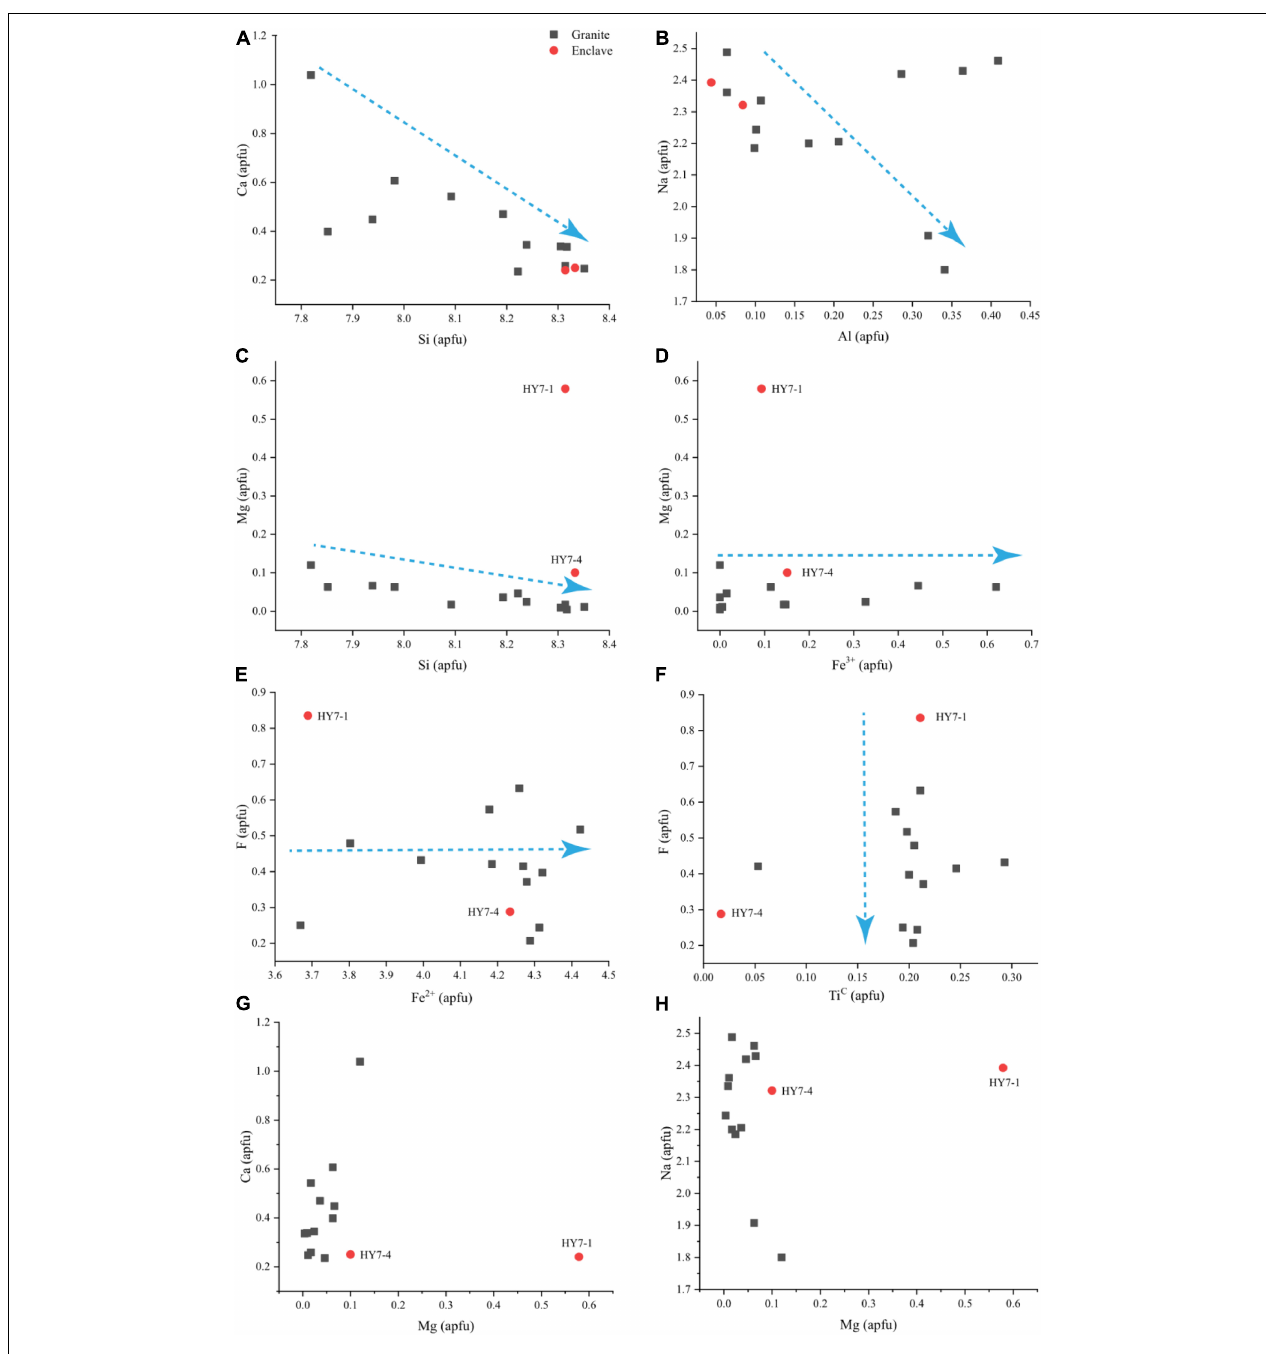
FIGURE 7 | Binary diagrams showing major elements concentrations of amphiboles in atoms per formula unit (apfu). (A) Ca versus Si; (B) Na versus Al; (C) Mg versus Si; (D) Mg versus Fe 3 + ; (E) F versus Fe 2 + ; (F) F versus Ti in C-site; (G) Ca versus Mg; and (H) Na versus Mg. In the plots, black squares represent chemical composition of granites-host amphiboles, red circles represent chemical composition of enclave-host amphiboles.